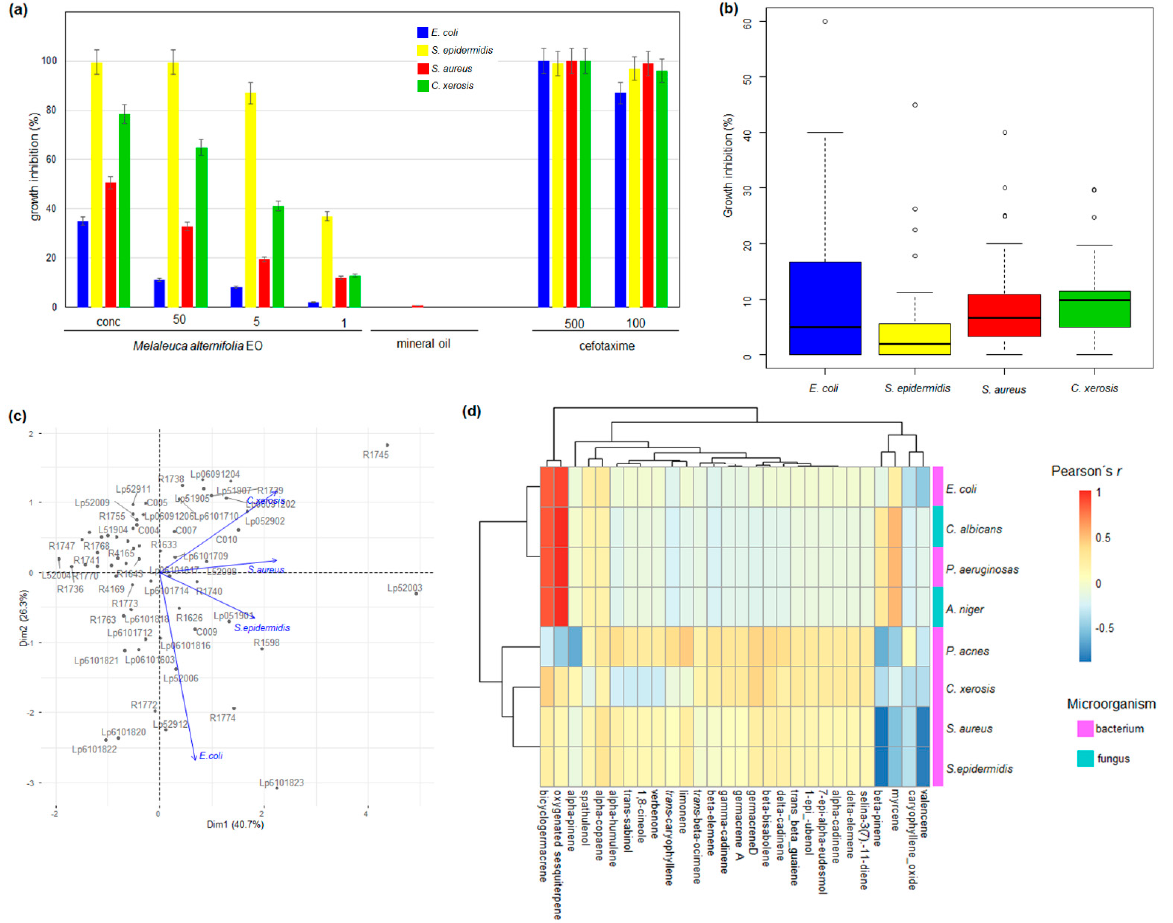
Figure 4. Biological activity of the EOs against pathogenic bacteria. ( a ) Dose-response estimation with positive and negative controls. ( b ) Growth inhibition amplitude for E. coli , S. aureus , S. epidermidis and C. xerosis . ( c ) PCA biplot of bacterial growth inhibition by the individual EOs. ( d ) Heatmap representation of the correlation between EO composition and minimum inhibitory concentration for pathogenic fungi and bacteria. Pearson’s correlation coefficients and their corresponding p − val- ues are shown in Table S2.